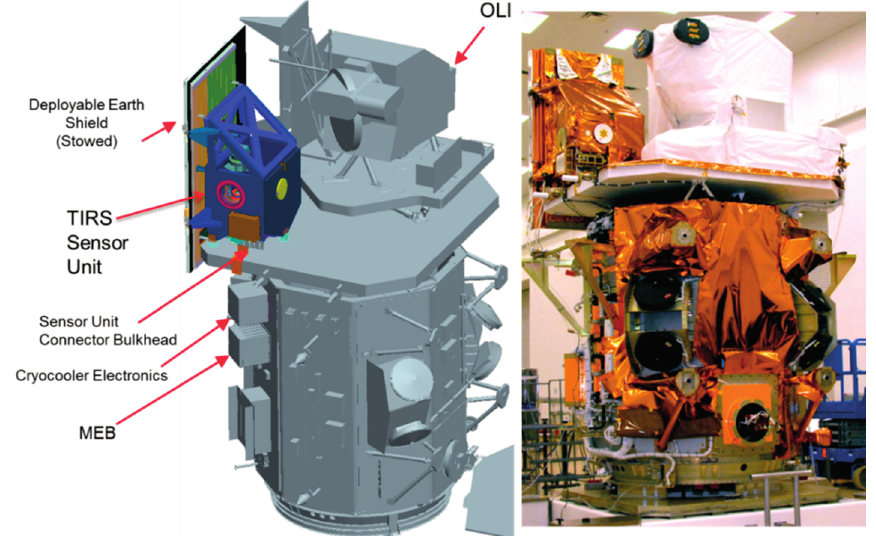
Figure 3. Drawing showing the location of various TIRS components on the spacecraft ( left ) and a picture of TIRS and OLI on the spacecraft prior to encapsulation ( right ).